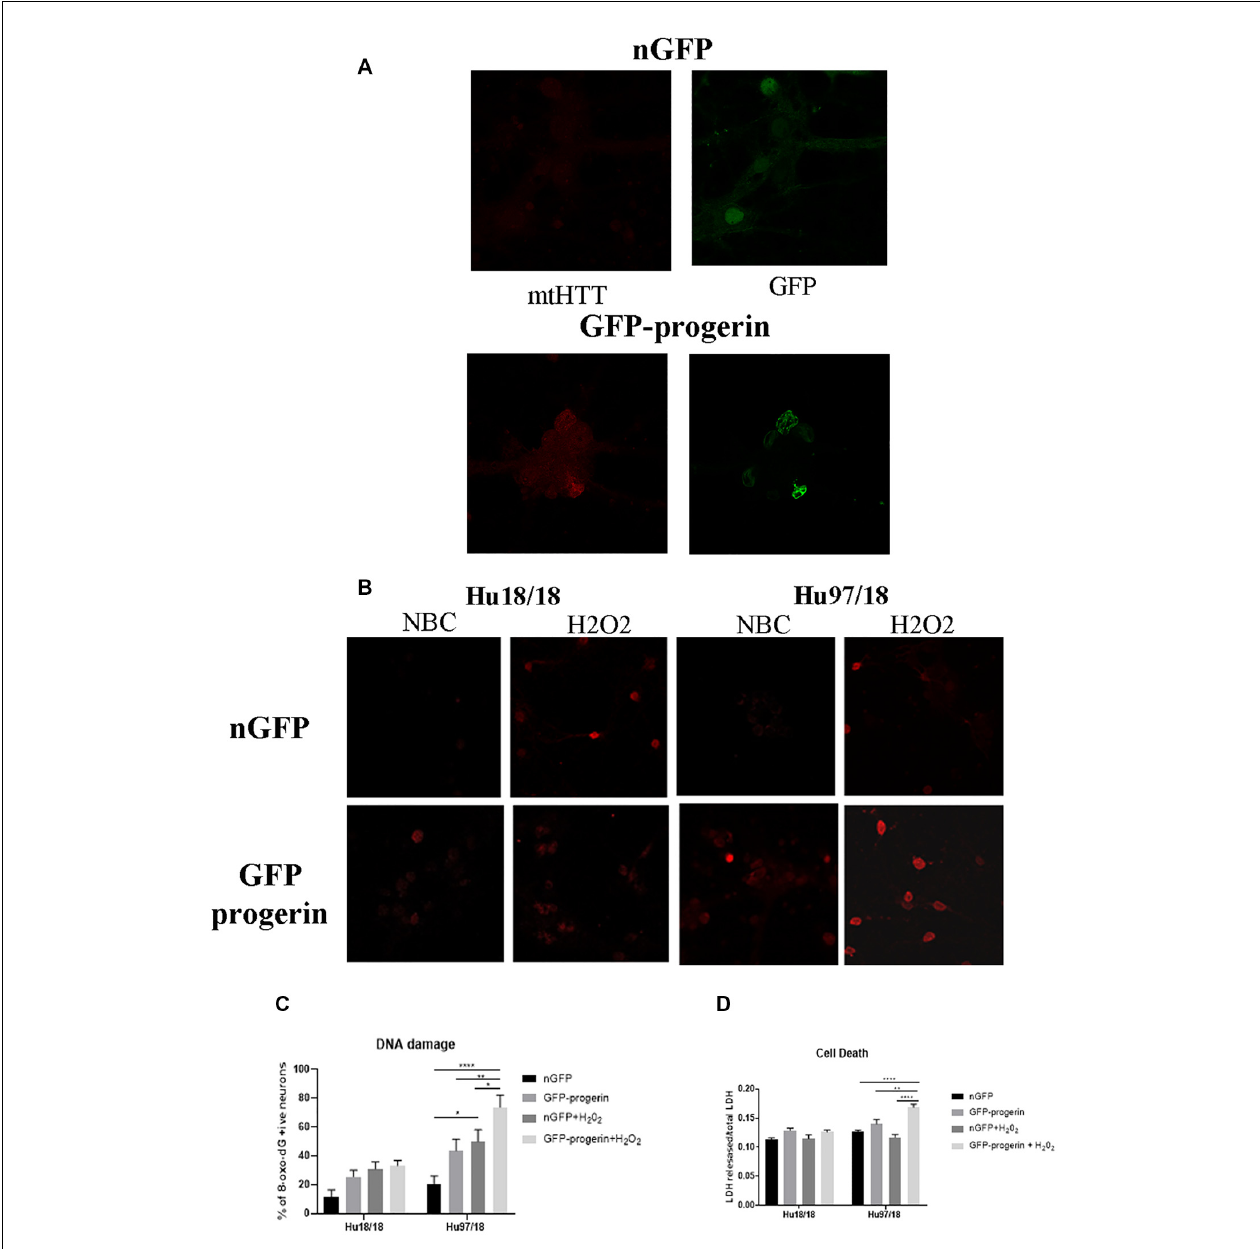
FIGURE 5 | Progerin treatment causes aggregate seeding/oligomerization of mutant HTT (mtHTT) and increased susceptibility to oxidative stress-induced DNA damage and cell death in HD neurons. (A) Mature Hu18/18 and Hu97/18 neurons were treated with nGFP or progerin to induce aging, and mtHTT was assessed by EM48 immunocytochemistry. (B,C) Mature Hu18/18 and Hu97/18 neurons were aged with progerin or given nGFP control followed by H 2 O 2 or vehicle control treatment. Oxidative DNA damage was assessed by Oxo-8-dG immunocytochemistry. Representative images (B) and quantitation of % of neurons exhibiting DNA damage (C) . (D) Mature primary Hu18/18 and Hu97/18 neurons were treated with nGFP or progerin followed by H 2 O 2 or vehicle control. Cell death was assessed by quantifying released/total lactate dehydrogenase (LDH). *Difference between indicated bars, * p < 0.05, ** p < 0.01, **** p < 0.0001. Error bars ±